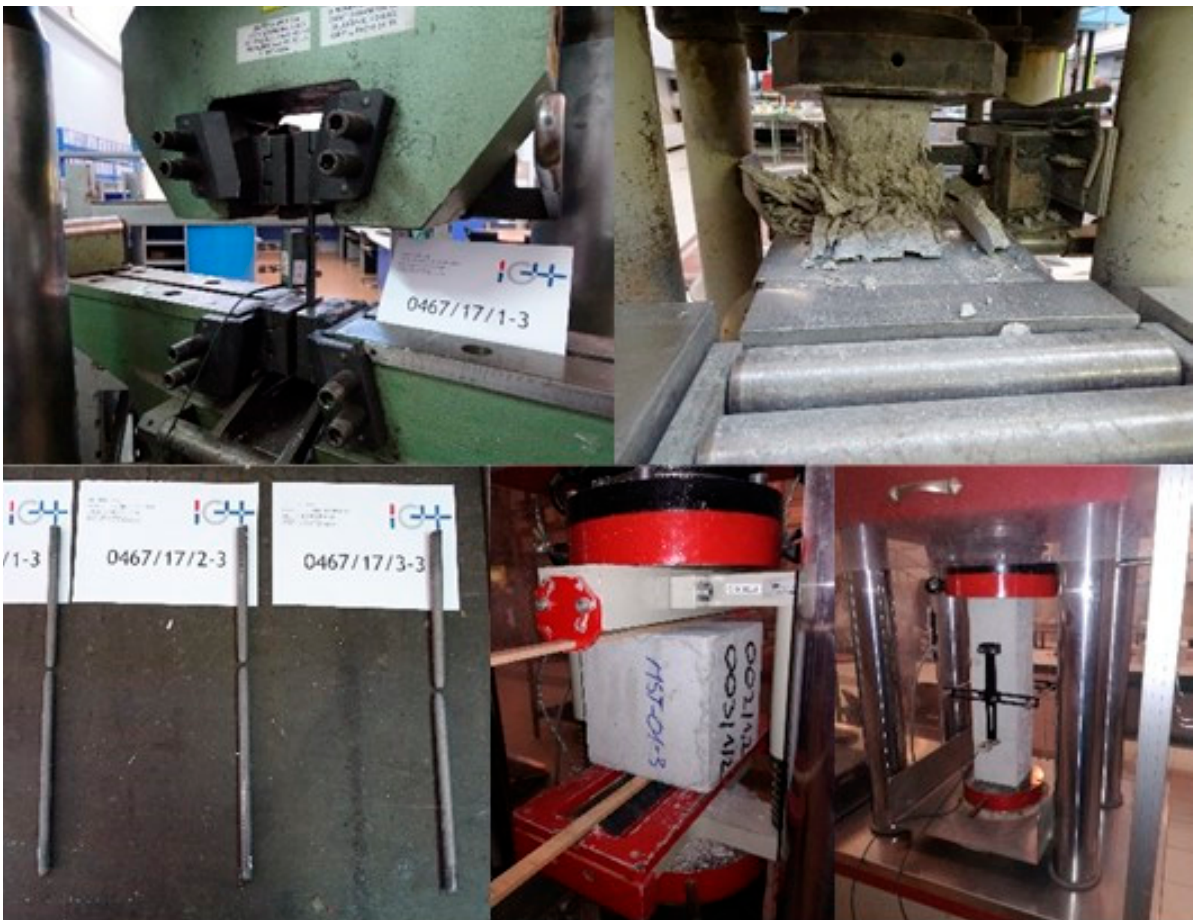
Figure 8. Performance testing of concrete and steel.